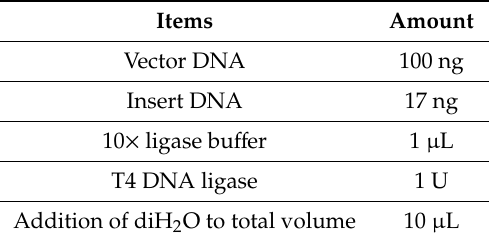
Table 2. Ligation response